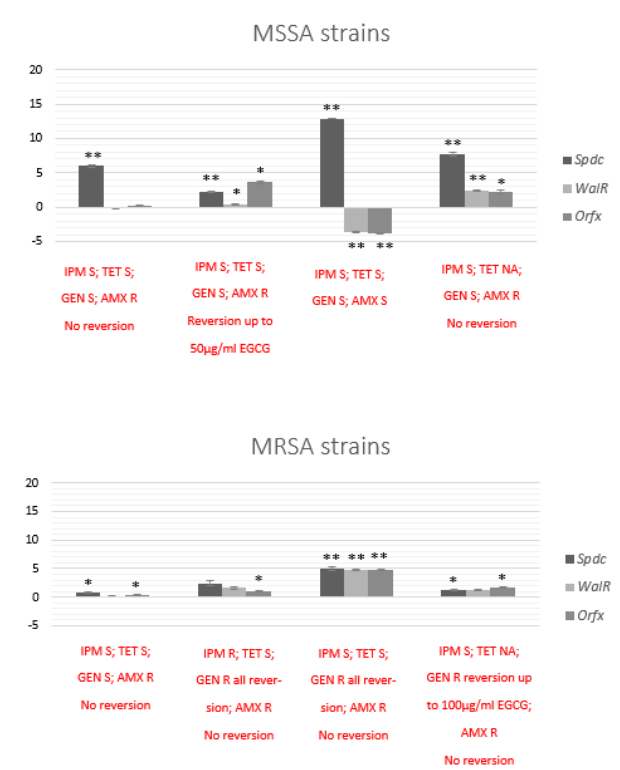
Figure 4. Graphic representation of qRT-PCR data analysis of selected MSSA ( A ) and MRSA ( B ) strains associated with EGCG exposure after 24 h of subculture. Data are representative of OrfX , SpdC and WalKR relative expression. 16S rRNA was used for normalization. Error bars represent the standard deviation between independent treatments and qRT-PCR replicates. Significant statistical values, which were compared with the most resistant strains and calculated with Student’s t -test, are illustrated as: * p < 0.01 and ** p < 0.001.